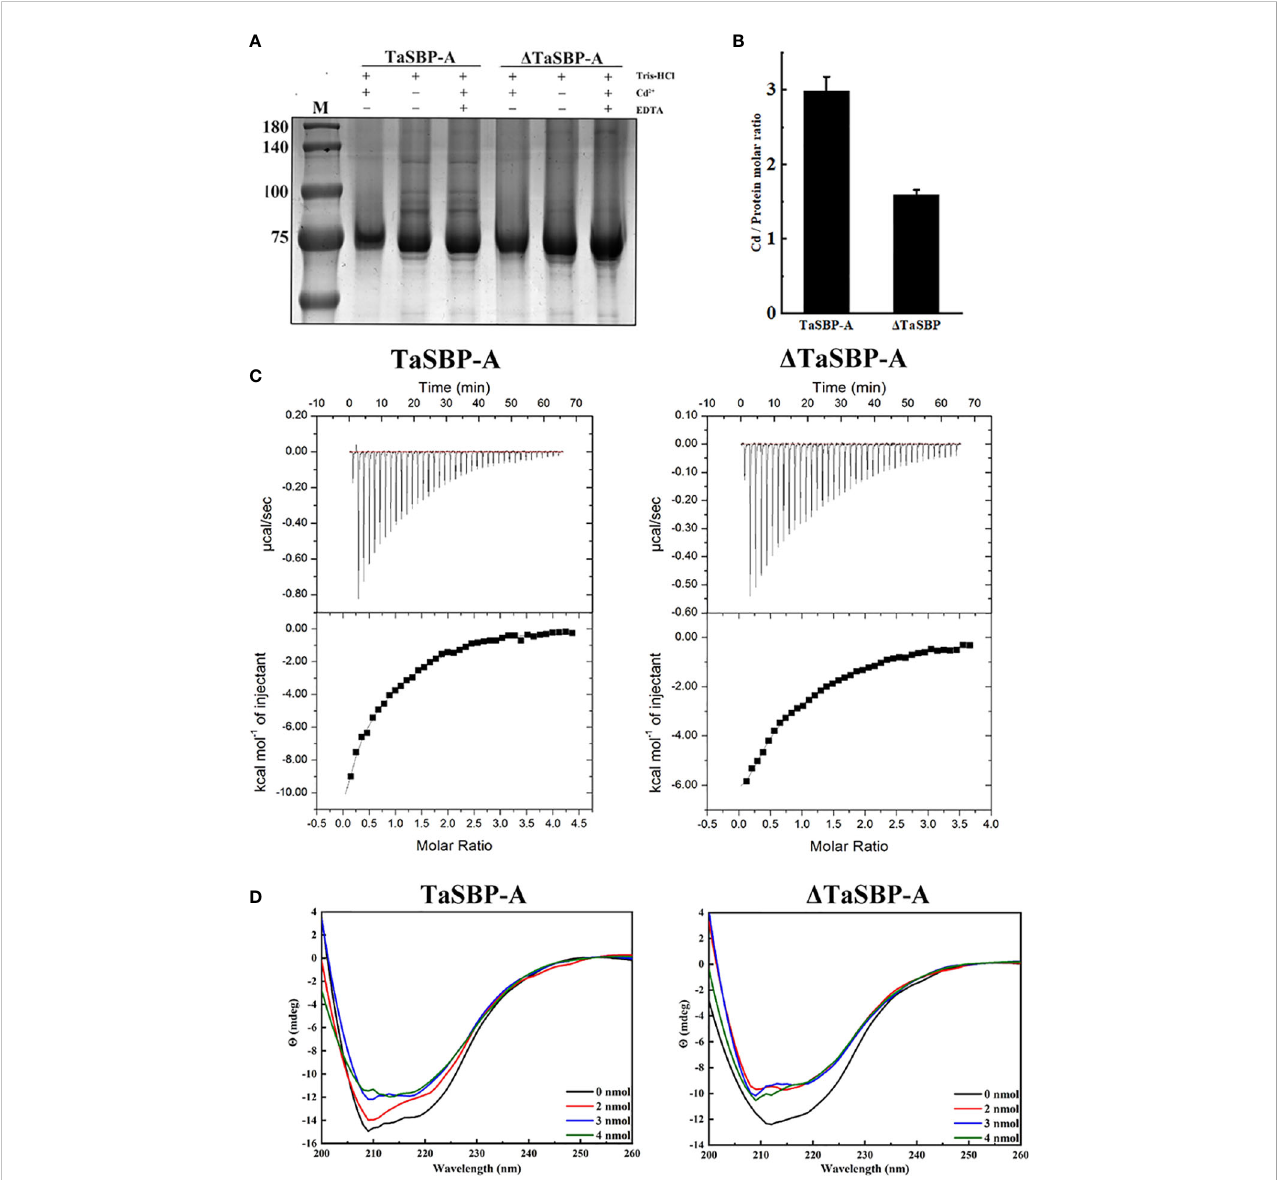
FIGURE 6 Determination of the Cd-binding site in TaSBP-A by in vitro Cd 2+ binding assay. (A) Cd 2+ -binding shift performed with 100 m M recombinant proteins and 0.5 mM Cd 2+ in vitro . Tris-HCl was used as a reaction buffer and EDTA was used as a competitive inhibitor to protein. (B) The Cd/Protein Ratio determined by ICP-MS. (C) Isothermal titration calorimetry experiments of the recombinant TaSBP-A (left) and D TaSBP-A (right) binding to Cd. The top panel dispalys the titration of Cd 2+ at 0.5 mM into TaSBP-A ( D TaSBP-A) at 50 m M placed at the sample cell; the bottom panel indicates the ligand concentration dependence of the heat released upon binding after normalization. The data were fi tted with the one-site binding model. The data are means ± SD from the three biological replicates. (D) CD spectra of the recombinant TaSBP-A (left) and D TaSBP-A (right) in the presence of a stepped Cd concentration (0-4 nmol Cd) at 25 °C. The protein content remained 1 nmol/250 m L during the whole experiment. The X and Y axes represent the wavelength (nm) and Y (mdeg),